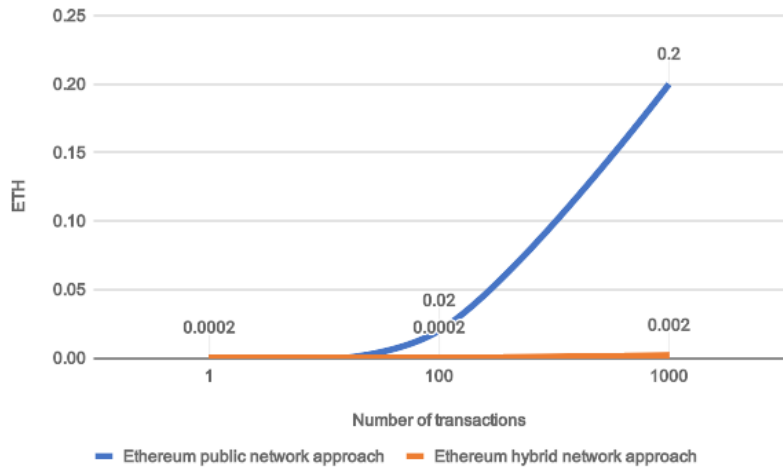
Figure 6. Cost comparison for public and hybrid Ethereum network